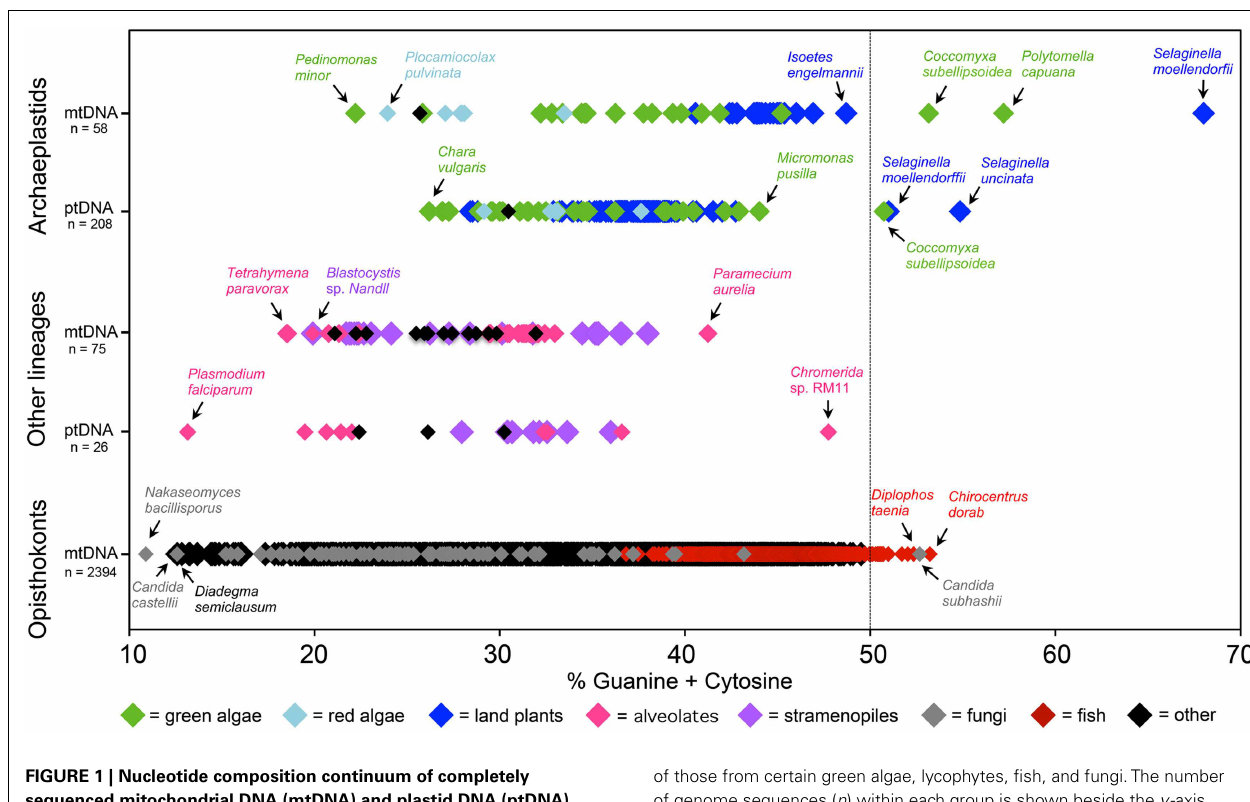
FIGURE 1 | Nucleotide composition continuum of completely sequenced mitochondrial DNA (mtDNA) and plastid DNA (ptDNA) sequences. Most of the complete organelle genome sequences deposited in GenBank have a GC content below 50%, with the exception